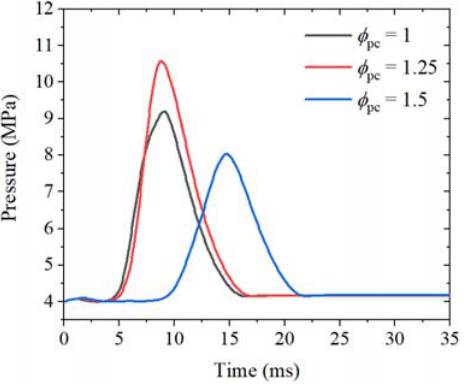
Figure 10. Pressure traces of prechamber for different prechamber global equivalence ratios.